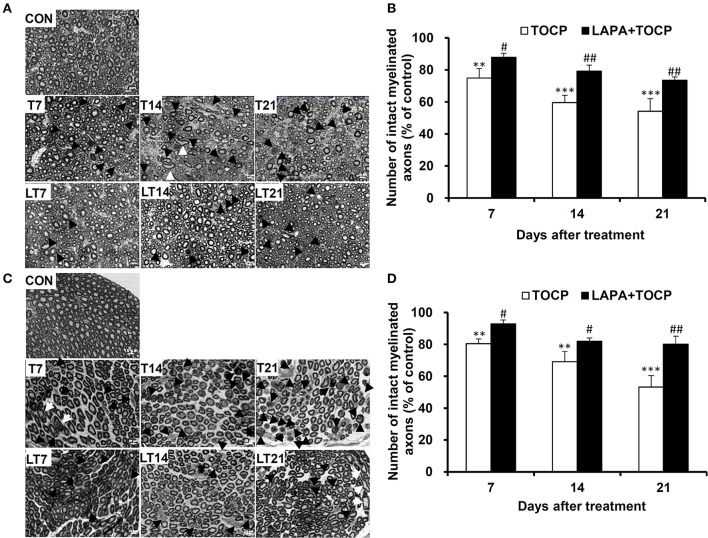
The histopathological changes following TOCP and lapatinib treatment. (A,C) The histopathological examination with semi-thin sections (200 nm thick) of anterior funiculus of lumbar spinal cord (A) and sciatic nerve (C). Black arrows, white arrows, and black arrowheads indicate degenerative, swollen, and demyelinated axons, respectively. Scale bar: 10 μm. (B,D) The quantified numbers of intact myelinated axons in the spinal cord (B) and sciatic nerve (D), which was shown in panels A and C, respectively. The mean numbers of intact myelinated axons in control groups of spinal cord and sciatic nerve are 5,078 ± 245 and 8,117 ± 738/mm2, respectively. **P < 0.01; ***P < 0.001 compared with the control group. #P < 0.05; ##P < 0.01 compared to the corresponding TOCP treatment group.